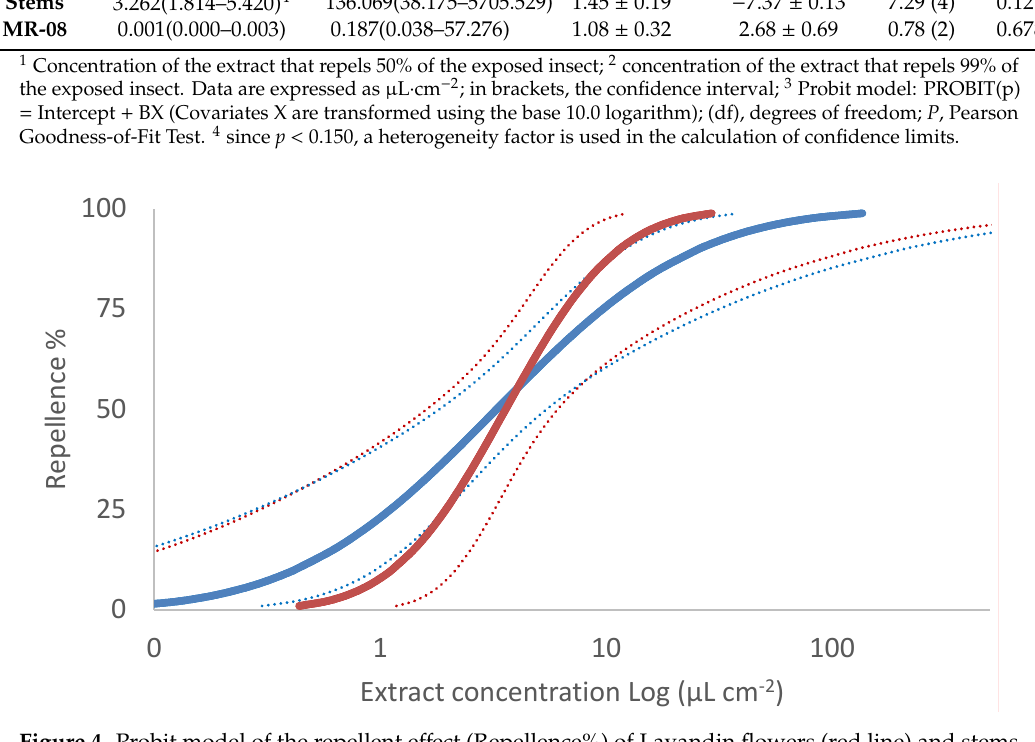
Table 2. Adjusted estimated marginal (EM) means of the repellence of Lavandin flowers and stems aromatic waters and of the synthetic repellent MR-08 against Tribolium confusum adults.